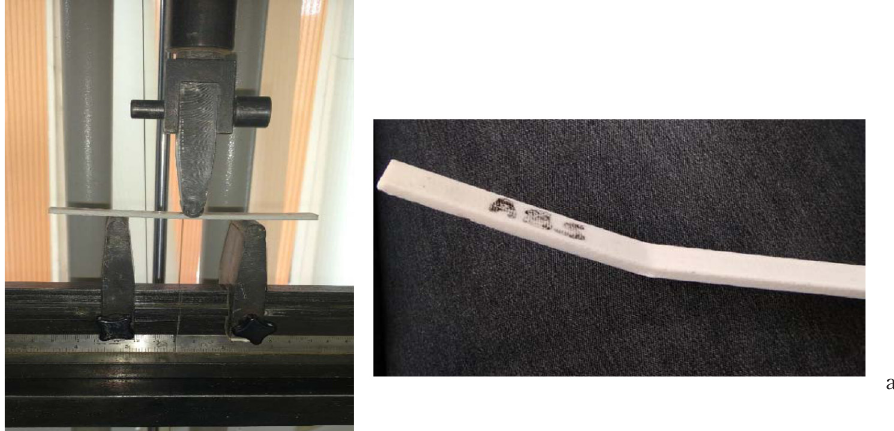
Figure 10. Experimental